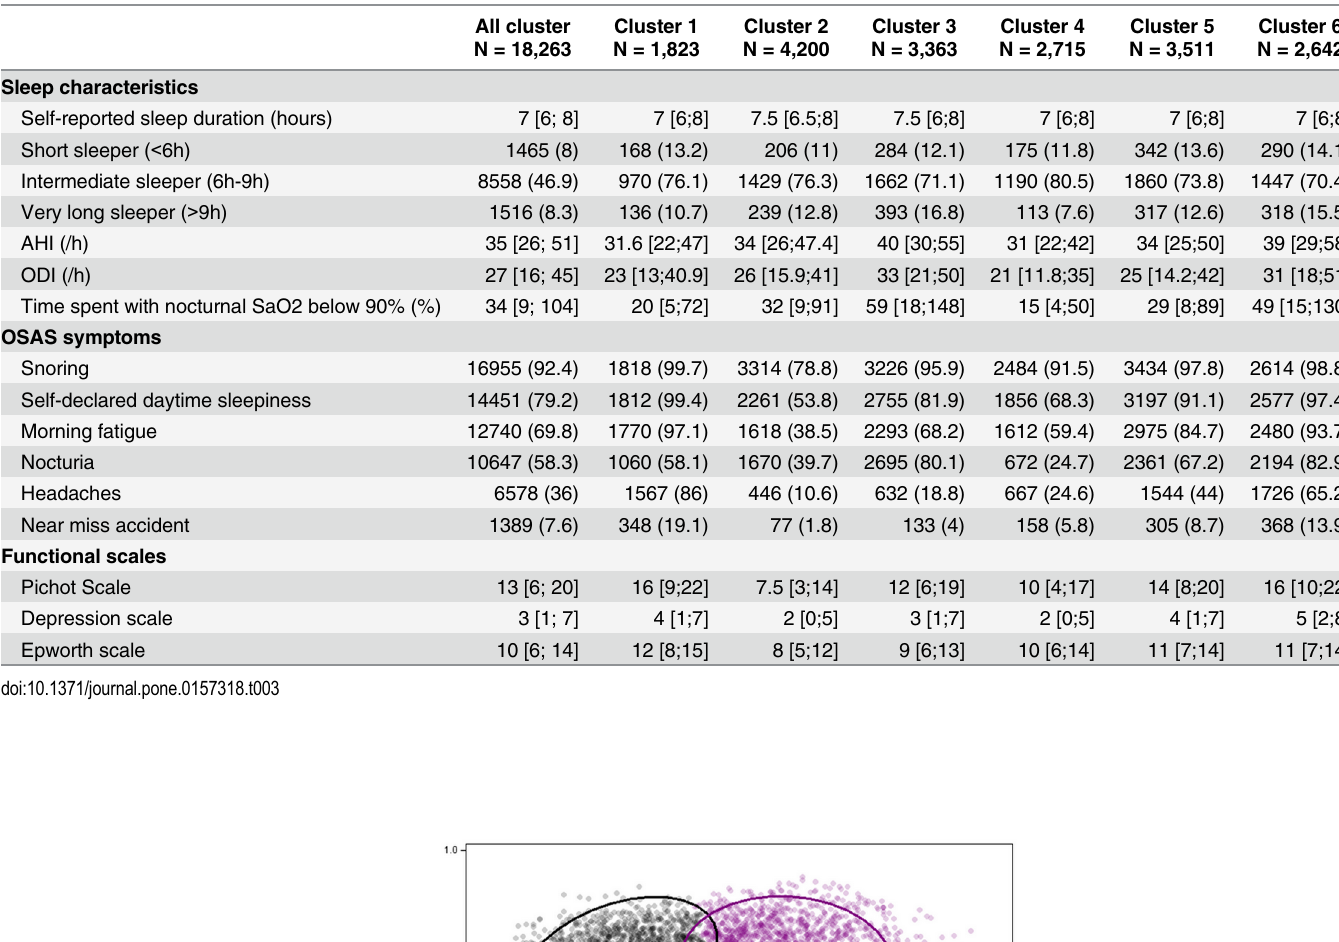
Table 3. Patients characteristics of the entire cohort and by clusters: Sleep characteristics, OSAS symptoms and functional scales. Values in Numbers (%) or median [IQR]. Obstructive Sleep Apnea Syndrome (OSAS), Apnea/Hypopnea Index (AHI), Oxygen Desaturation Index (ODI). Cluster 1: the young symptomatic. Cluster 2: the old obese. Cluster 3: the multi-disease (MD) old obese. Cluster 4: the young snorers. Cluster 5: the drowsy obese. Cluster 6: the MD obese symptomatic.